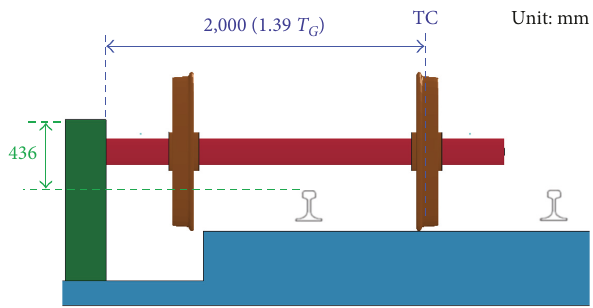
Figure 16: Overview of height effect 1.